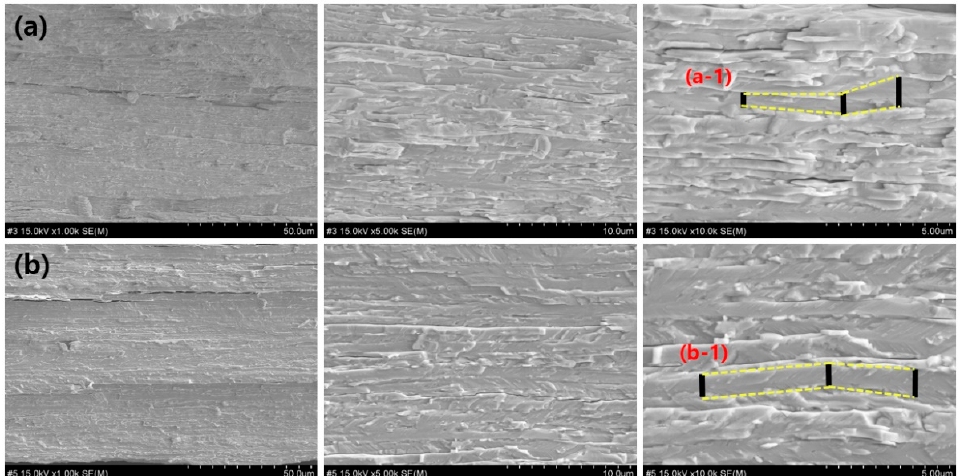
Figure 4. Sectional analysis of tungsten plate: ( a ) hot-rolling method; ( b ) cold-rolling method. ( a - 1 ) shows an irregular laminated structure, and ( b - 1 ) shows a regular laminated structure.